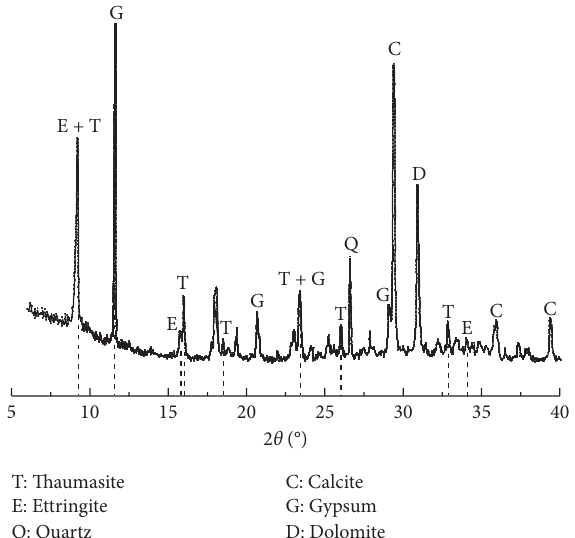
Figure 7: XRD pattern of tunnel lining concrete under TSA.